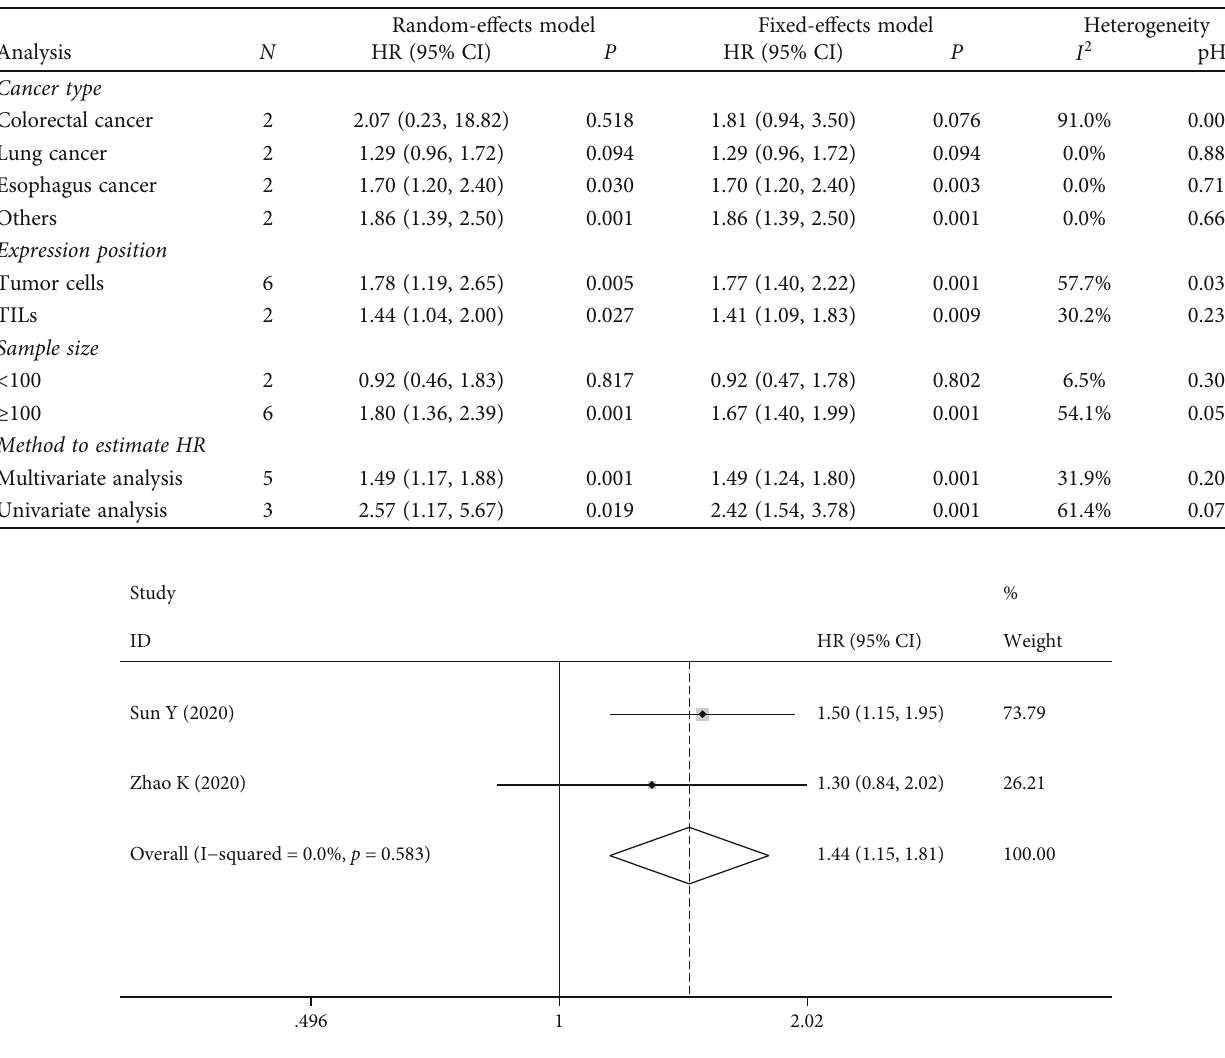
Table 2: Subgroup analysis results.